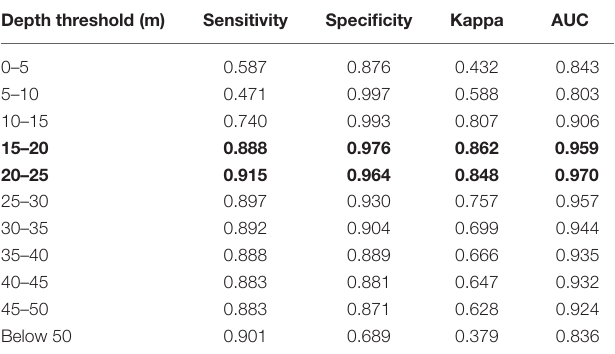
TABLE 2 | An example of the effect of varying the depth threshold of dispersal on the accuracy of the predicted population distribution, all other parameters being held